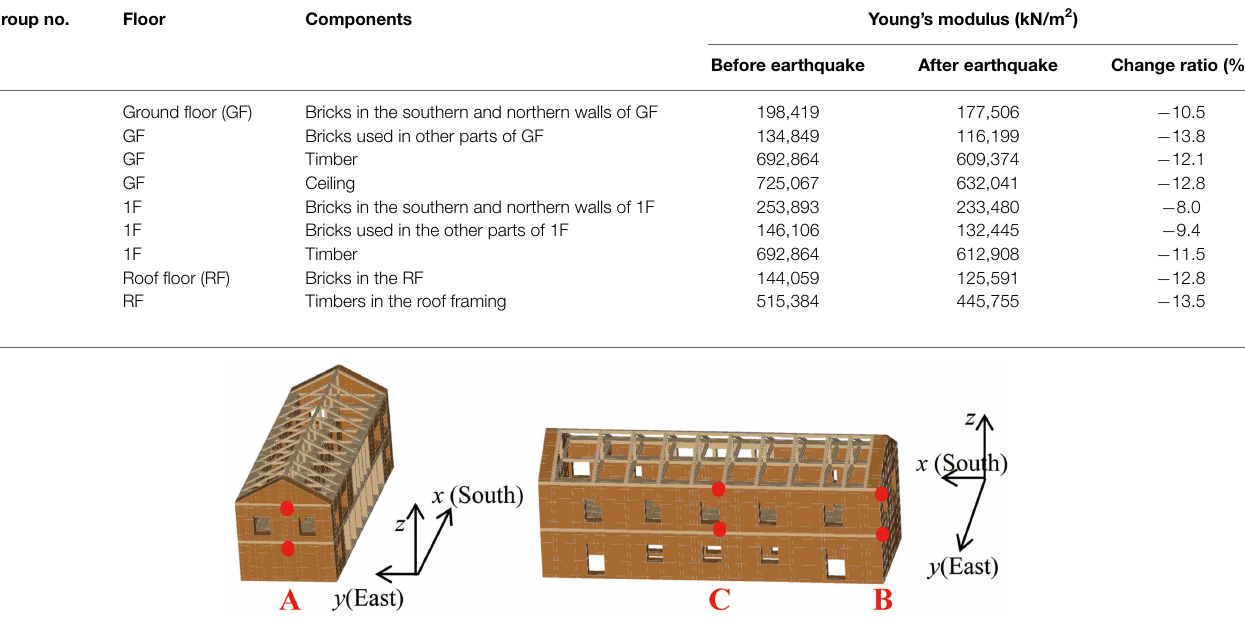
FIGURE 10 | The location of reference